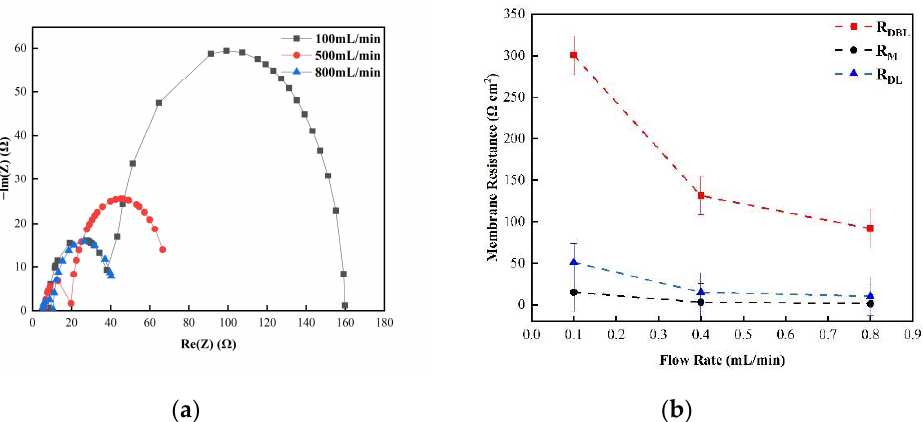
Figure 6. ( a ) The impedance of the Nyquist spectrum and ( b ) membrane impedance R M , double layer impedance R DL , and diffusion layer R DBL of the AEM membrane in a 0.05 M NaCl solution.